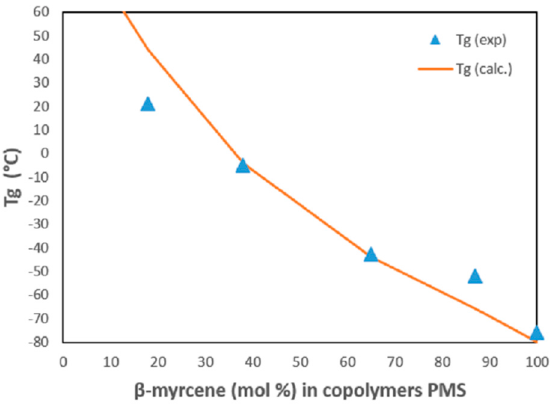
Figure 3. Glass transition temperatures (T g ) at different β -myrcene content (mol %) incorporated in copolymers.